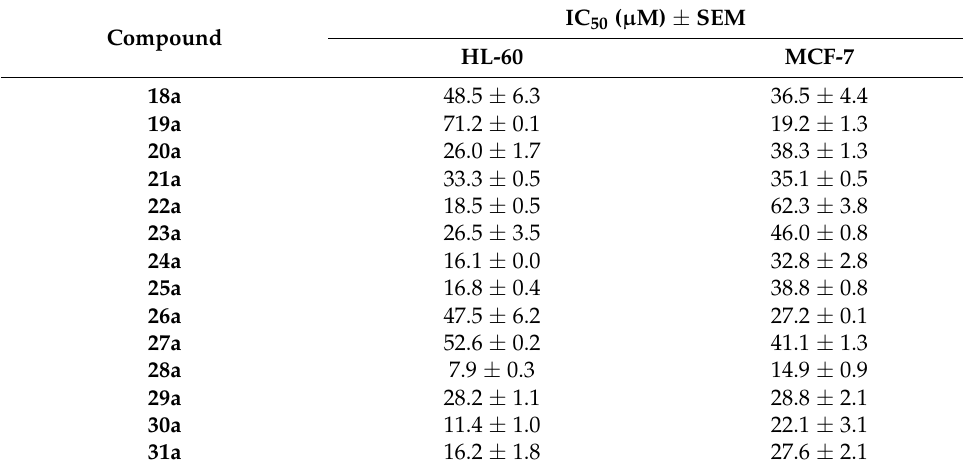
Table 2. The antiproliferative activity of compounds 18a – 31a .